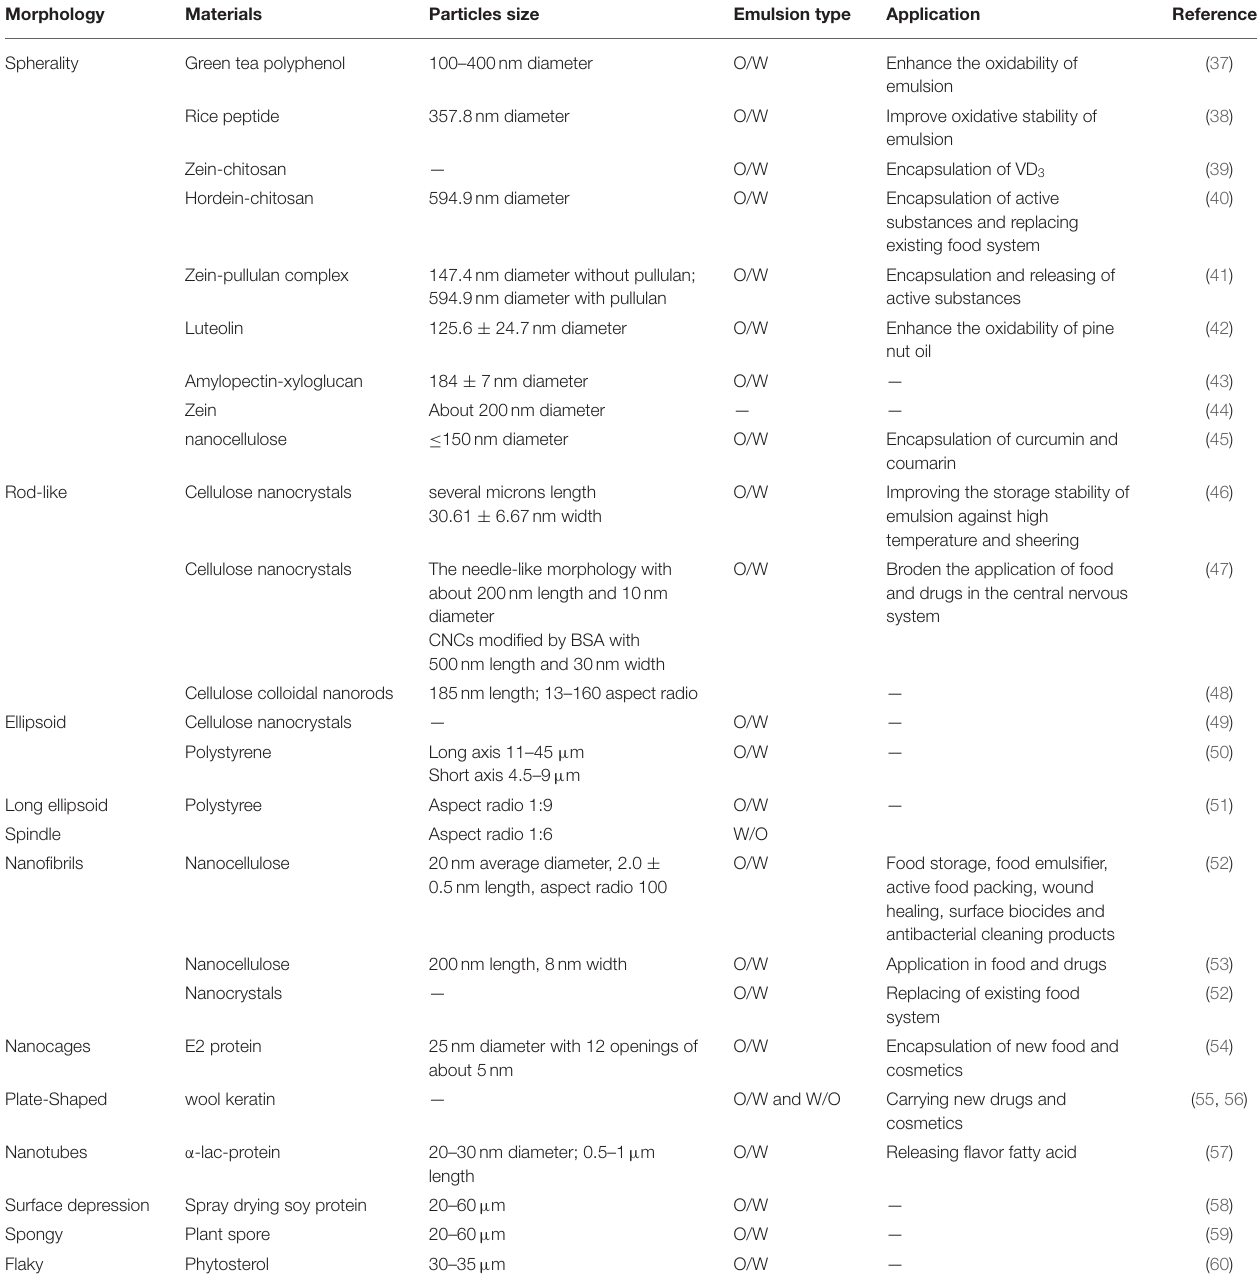
TABLE 1 | Different shapes of food-grade